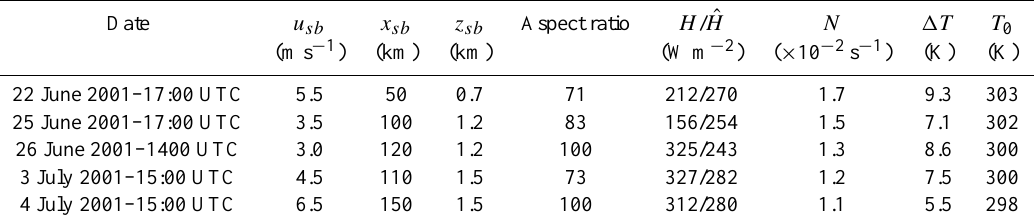
Table 2. Sea breeze inland penetration range and depth as derived from the airborne Doppler lidar measurements and the surface wind and temperature data from the operational meteorological network. The aspect ratio is defined as the ratio of the sea breeze inland penetration and the sea breeze depth.